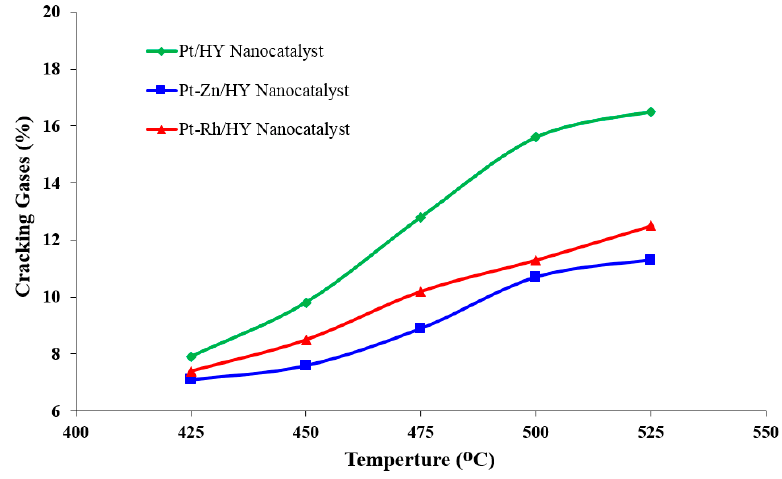
Figure 6. Influence of the catalytic reforming temperature on the cracking reaction over the synthe- sized Pt/HY, Pt-Zn/HY, and Pt-Rh/HY nanocatalysts. Al-Shathr et al. [14], Zhang et al. [22], Said-Aizpuru et al. [29], and Rabe [46] indicated